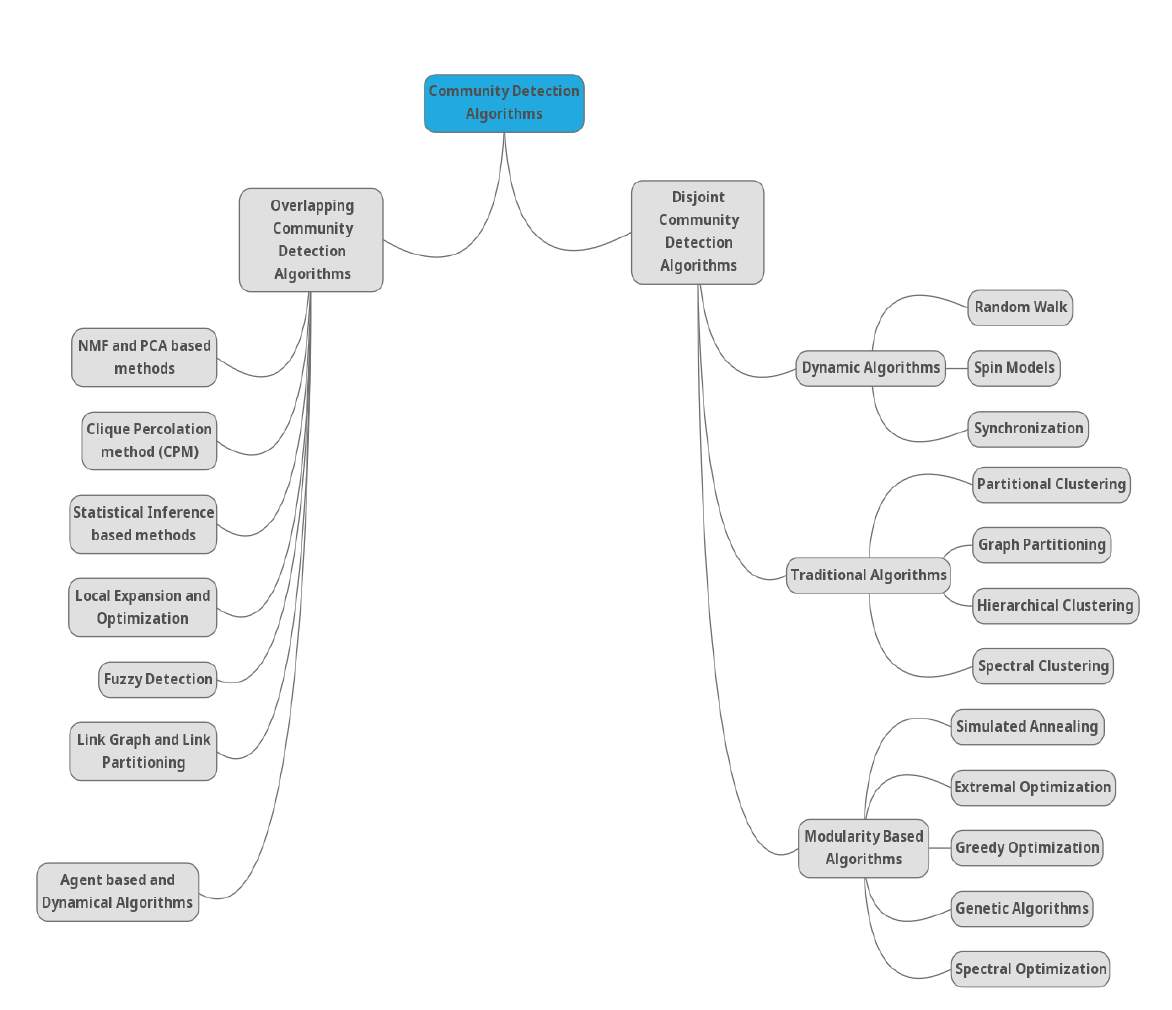
Figure 2 . Taxonomy of Community Detection Algorithms adopted from